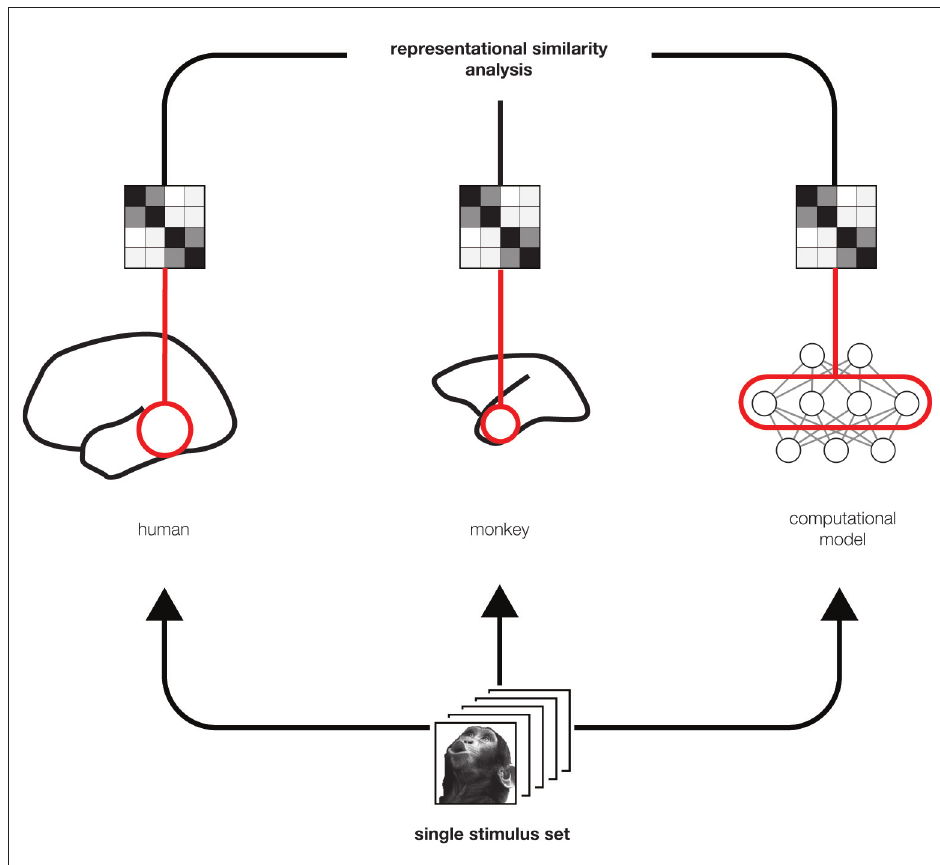
Figure 2 | Integrated analysis of population codes in man, monkey and models. Humans, monkeys, and computational models are presented with the same particular stimulus images so as to obtain representational dissimilarity matrices ( Figure 1 ). This allows us to compare the representations between putative functionally homologous regions and to test which computational models can explain each brain region’s